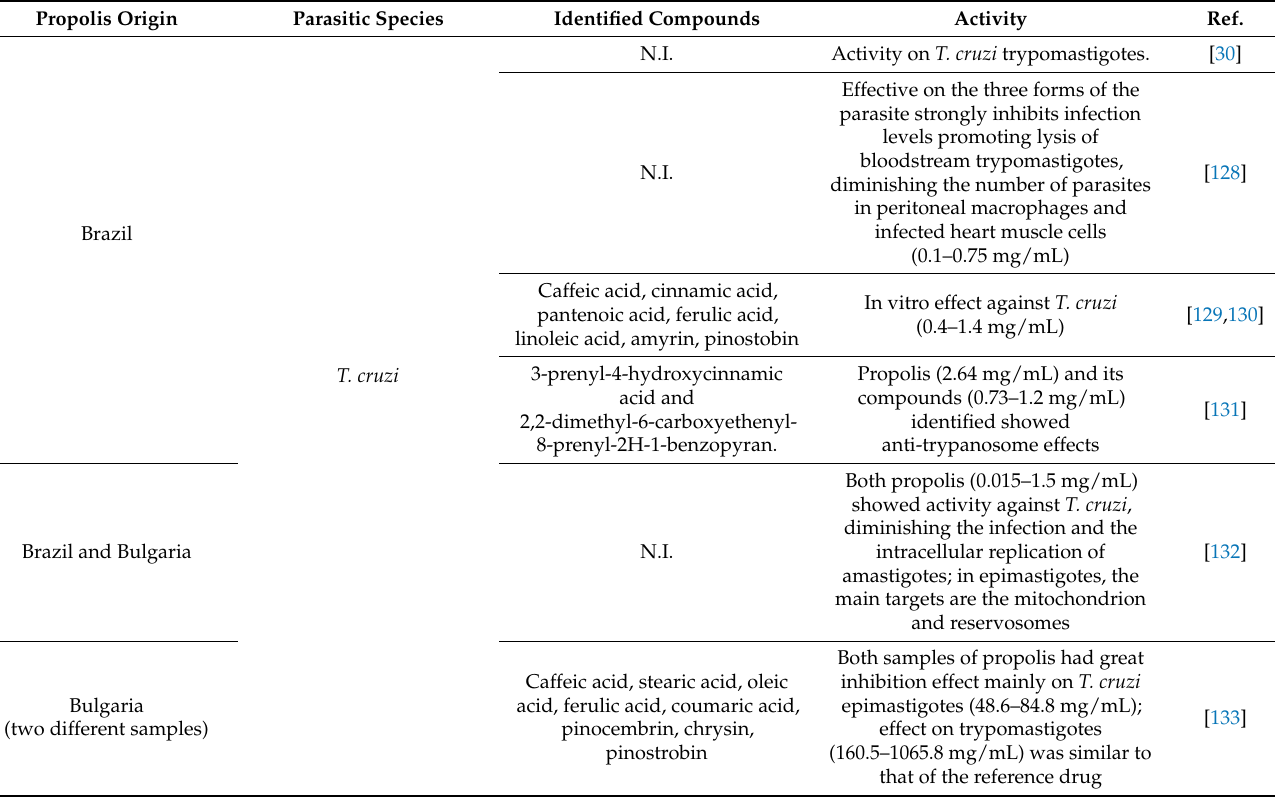
Table 12. Anti-trypanosome activity of different propolis and its chemical